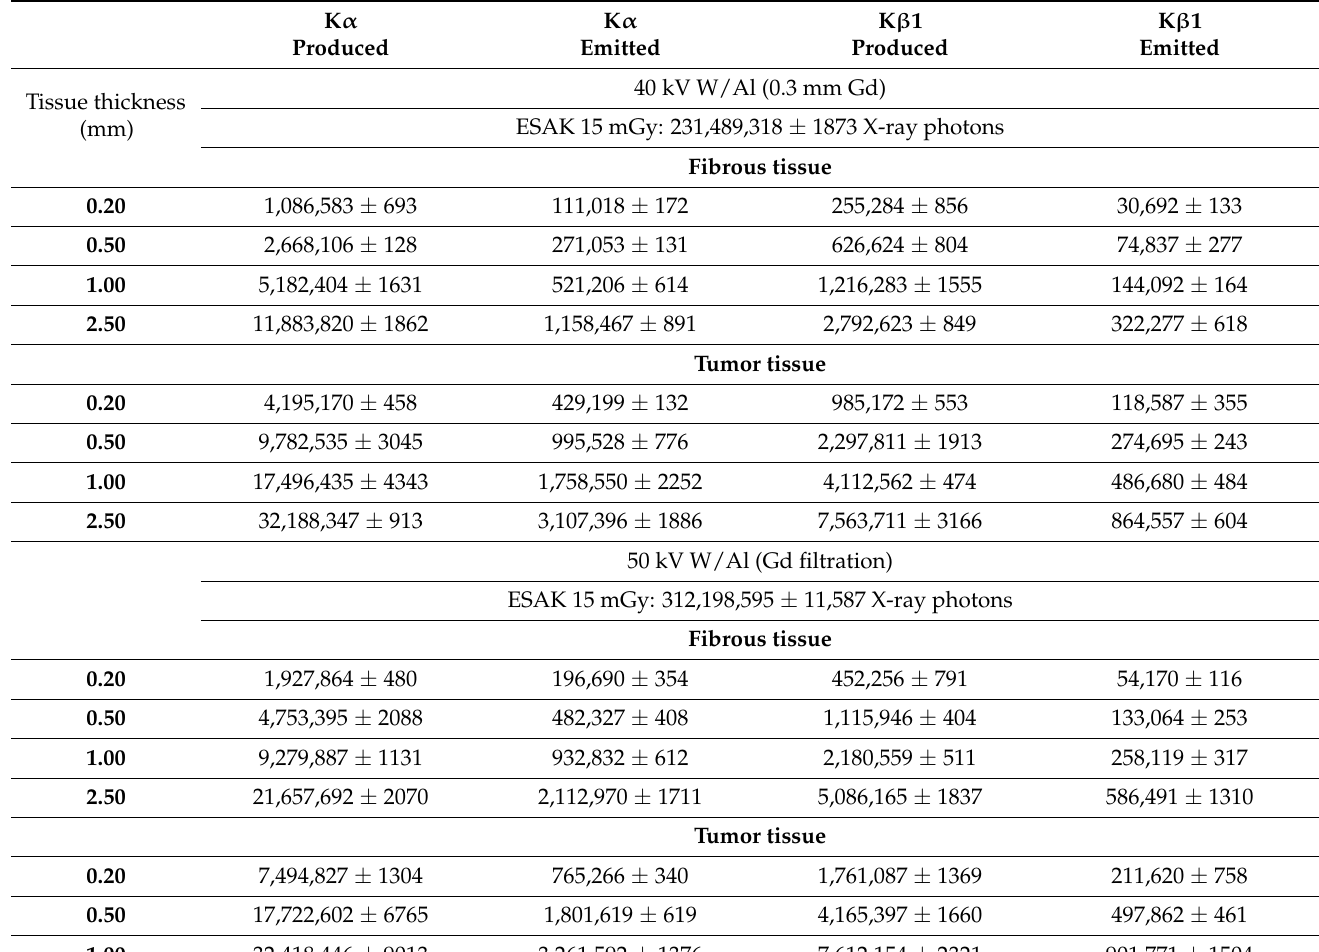
Table 3. Table shows the number of Iodine K -X-rays ( K α and K β 1 ) produced and emitted as well as the initial number of X-ray photons (corresponding to 15 mGy ESAK). Results are provided for: (a) two X-ray spectra: 40 kV- W/Al (1.6 mm) and 50 kV- W/Al (1.6 mm) with additional filtration 0.3 mm Gd; (b) two types of internal tissue (fibrous and tumor) with thicknesses ranging from 0.2 mm up to 2.5 mm; and (c) external fat tissue of 8 cm thickness. Numerical values are expressed by the mean value and their corresponding standard